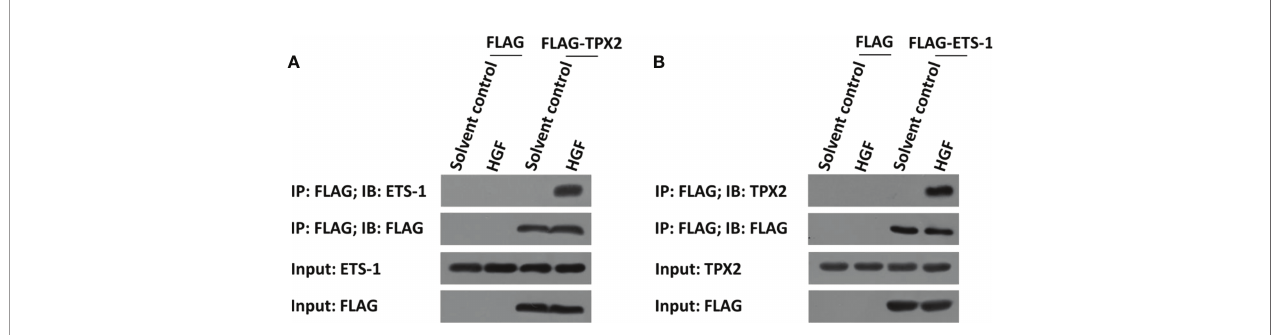
FIGURE 2 | TPX2 interacted with ETS-1 in PC-3 cells. Cells were treated with the solvent control or 10ng/ml concentration of HGF. (A) PC-3 cells were transfected with FLAG or FLAG-TPX2. (B) PC-3 cells were transfected with FLAG or FLAG-ETS-1. The cells were analyzed using the IP methods.